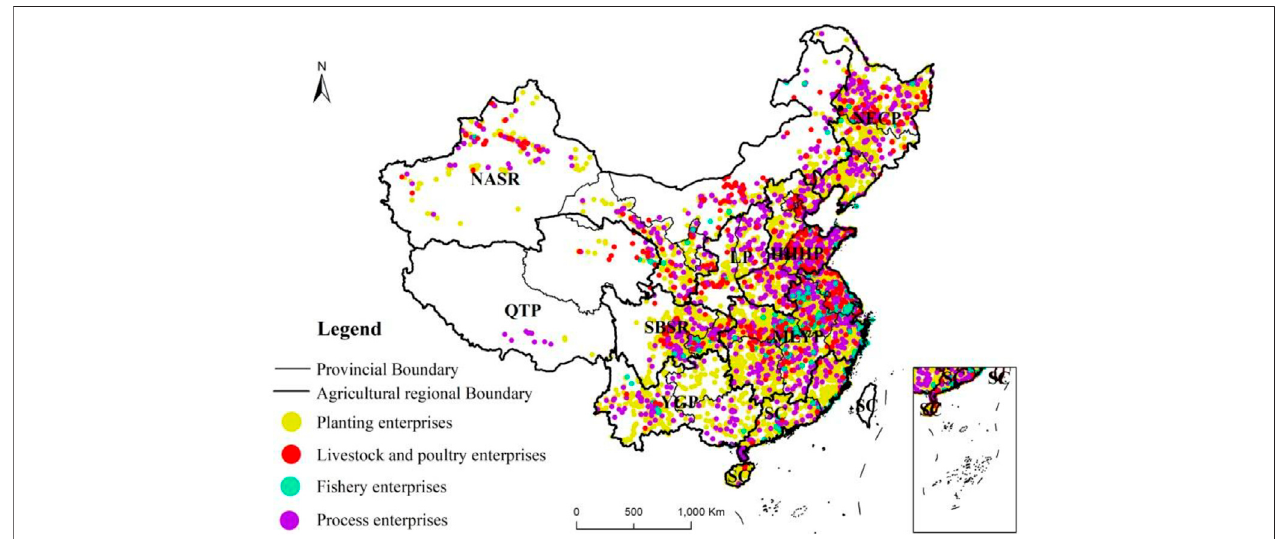
FIGURE 1 | Spatial distribution of China ’ s certi fi ed green food enterprises in nine geographical zones.